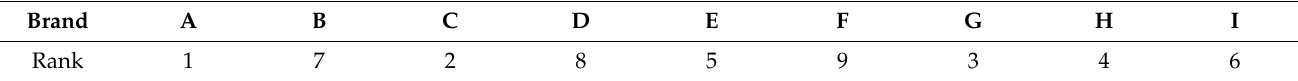
Table 13. The ranking of brand